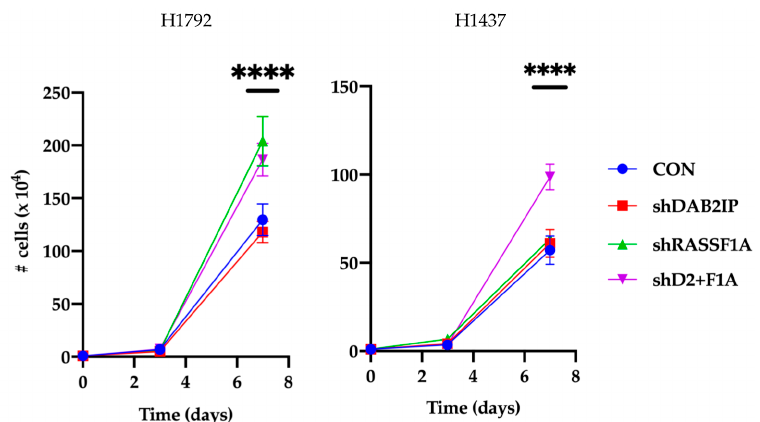
Figure 4. Effects of RASSF1A and DAB2IP suppression on in vitro 2D growth. Stably transfected NCI-